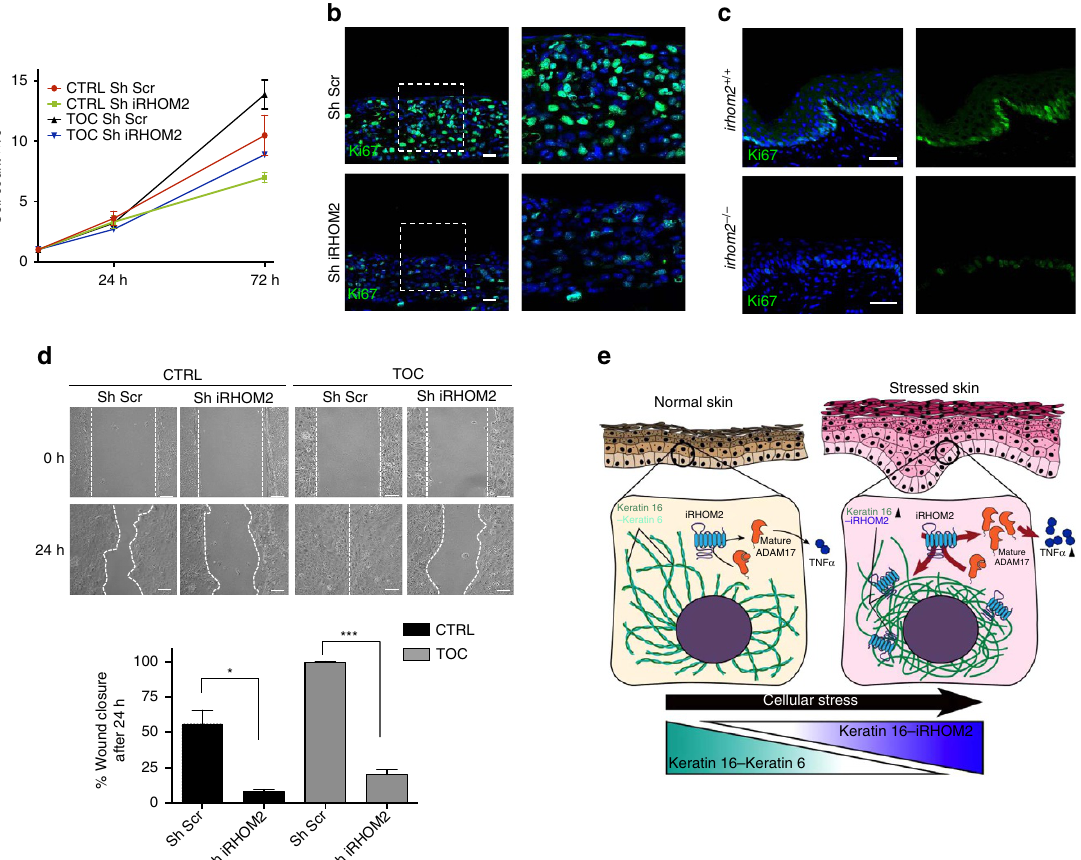
Figure 5 | iRHOM2 regulates migration and proliferation. ( a ) Growth curves of cultured cells for Sh-Scr, Sh-IRHOM2 in CTRL and TOC keratinocytes showing slower growth rates for Sh-iRHOM2 cells in both cell lines (mean of three independent experiments). ( b ) Confocal analysis showing the reduction of Ki67 expression in Sh-IRHOM2 TOC 3D human skin equivalents. Scale bars, 20 m m. ( c ) Confocal analysis confirming the reduction of Ki67 expression in the forepaw epidermis of irhom2 (cid:2) / (cid:2) mice. Scale bars, 20 m m. ( d ) Light-microscopy images of CTRL and TOC keratinocyte monolayers 0 and 24h after scratch-wounding. Graph shows quantification of wound closure, mean of three experiments. Error bars denote s.d. * P o 0.05 and *** P o 0.001 (Student’s t -test). Scale bar, 20 m m. ( e ) Model of iRHOM2-mediated regulation of K16 in stressed